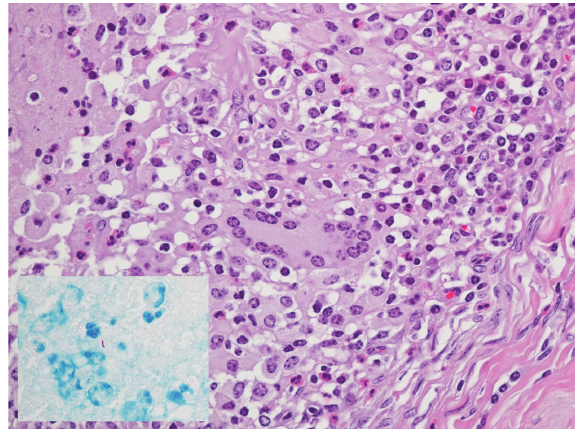
Figure 2: Microscopic lesions in elk. The image is a photograph of a representative pulmonary granuloma in an elk (hematoxylin and eosin stain). Note the large number of neutrophils and the single multinucleate giant cell in the center of the image. The inset image demonstrates an acid-fast bacillus (Ziehl-Neelson stain) in a pool of proteinaceous fluid, necrotic cell debris, and degenerate